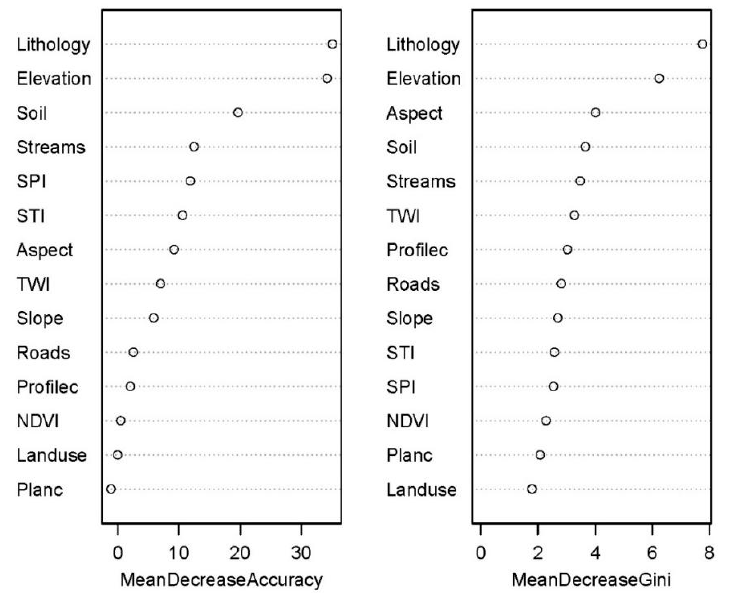
Figure 6. Mean decrease accuracy and mean decrease Gini (Streams: Distance to streams; Roads: Distance to roads; Planc: Plan curvature; Profilec: Profile curvature).